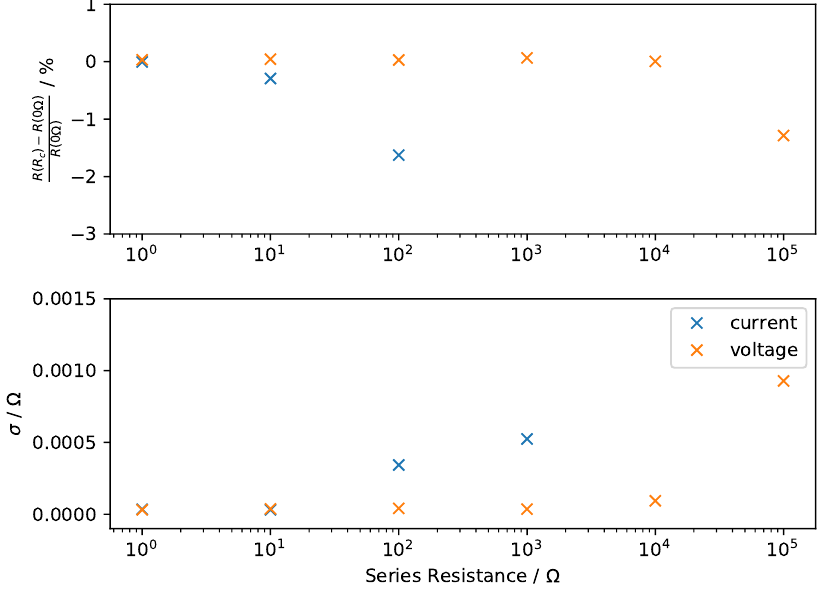
Figure 1. Influence of series resistance added to either current or voltage contacts of the Keithley DMM6500 for the four-wire measurement of a 14m Ω resistor. ( top ): Relative change of measured resistance ( bottom ): Standard deviation of the acquired resistances in